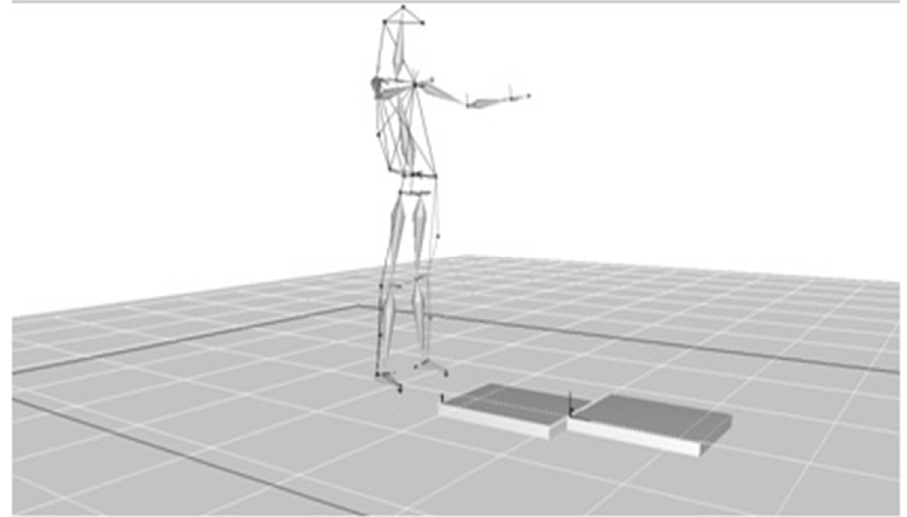
Figure 6. Representation of trunk and limbs following static acquisition.